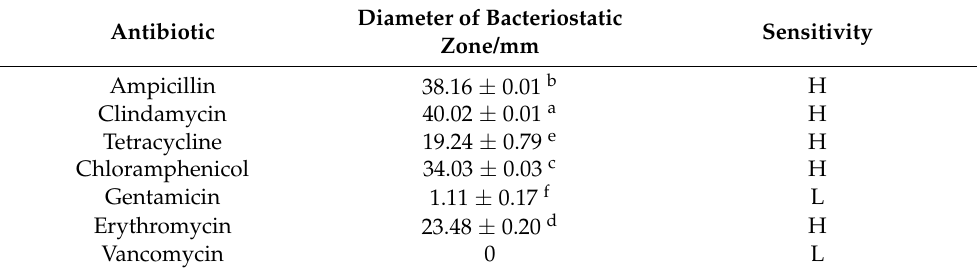
Table 2. Drug resistance of L. plantarum